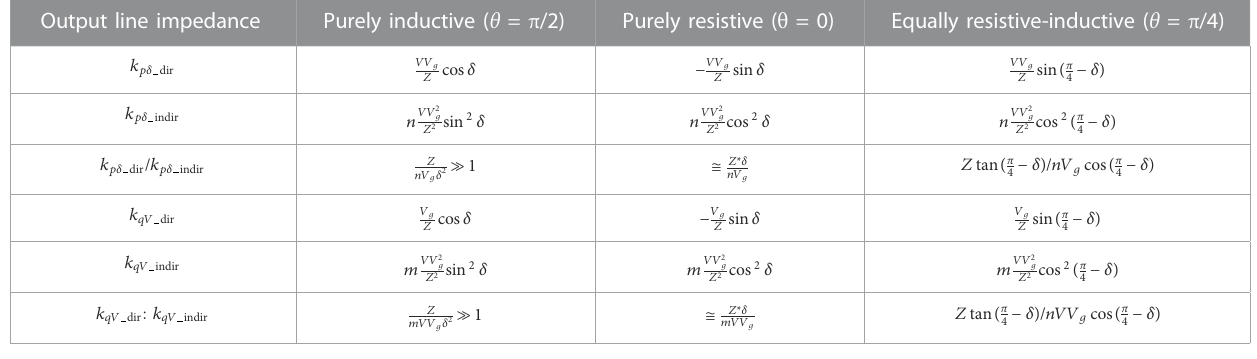
TABLE 4 Power coupling characteristics based on different line impedance conditions. Output line impedance